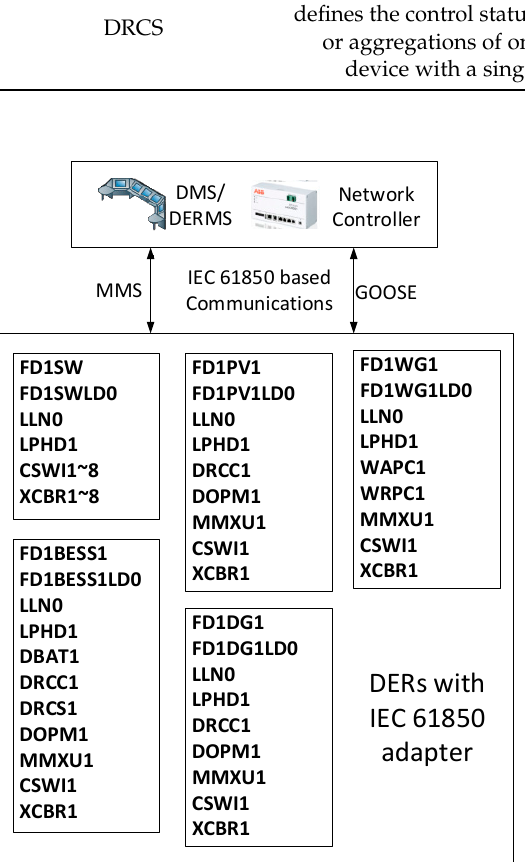
Figure 1. Logical nodes of IEC 61850 based adapters for each Distributed Energy Resource (DER) and breaker. Table 1. Logical nodes for Figure 1.